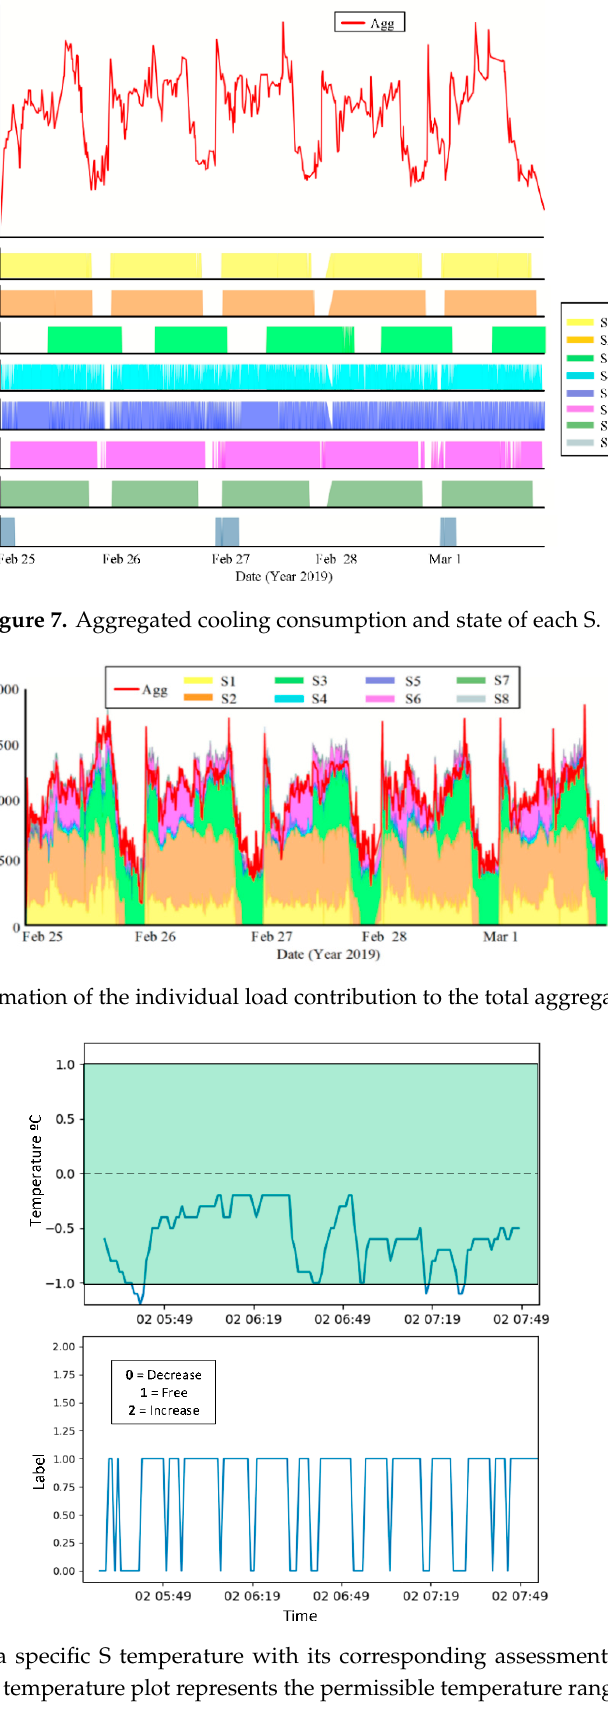
Table 3. h parameters values.